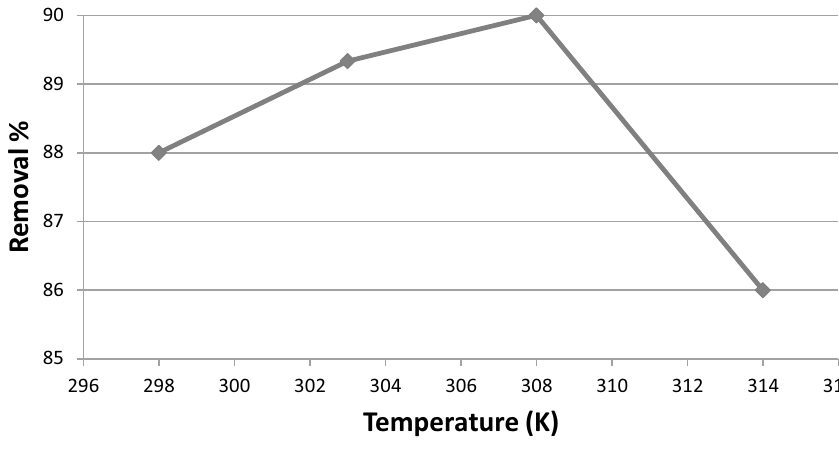
Fig. 11 The effect of tempera- ture on CR